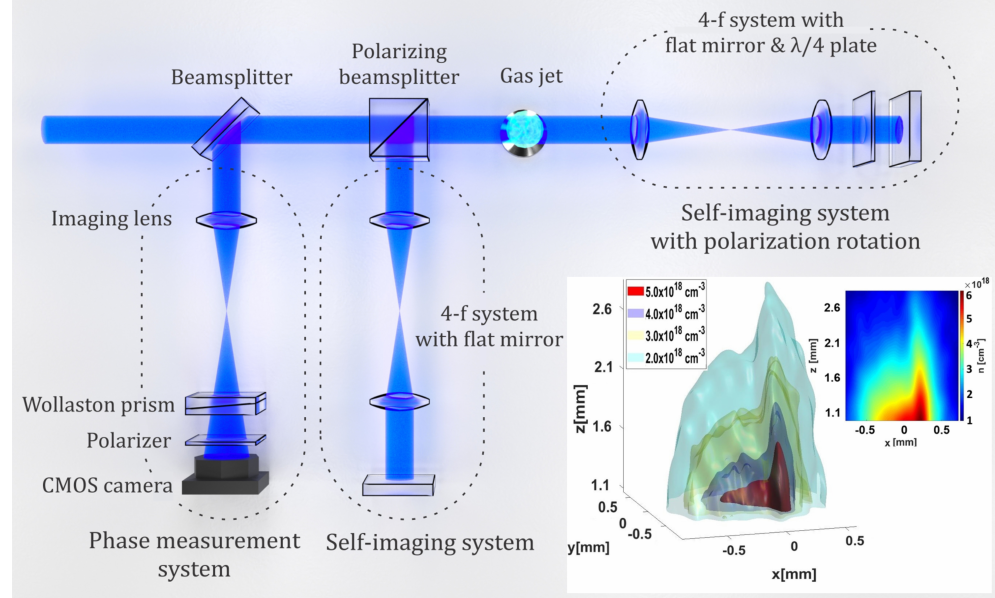
Figure 8. Schematic of the four-pass interferometric gas jet characterization. Tomograph of the density reconstruction of a helium gas jet (with a back-pressure of 7 bar) obstructed by a razor blade placed above the nozzle (inset), adapted from